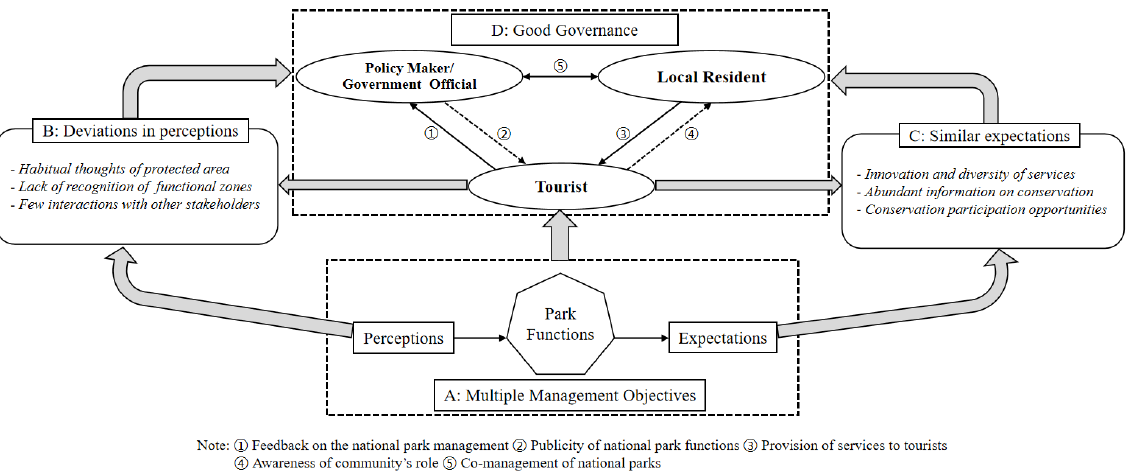
Figure 4. A synergistic governance mechanism of the national park extracted from tourists’ under- standing.